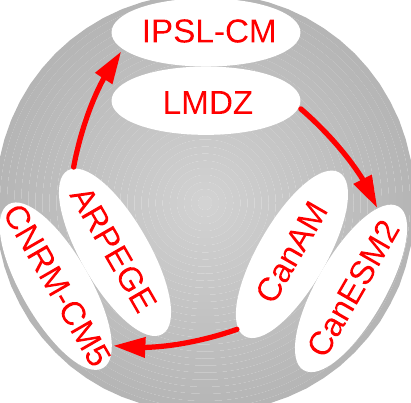
Fig. 5 Setup of the perfect model experiment. Arrows indicate which AGCM emulates which CMIP5 coupled model (CM); for example, LMDZ emulates CanESM2. The AGCMs are corrected towards their respective target coupled model for the 1981 – 2000 period, using the SST and sea-ice concentration from the target CM. They are then run into the future under the RCP8.5 scenario, using SST and sea-ice anomalies from their own coupled model (for example, IPSL-CM in the case of LMDZ). The uncorrected control runs use the same oceanic boundary